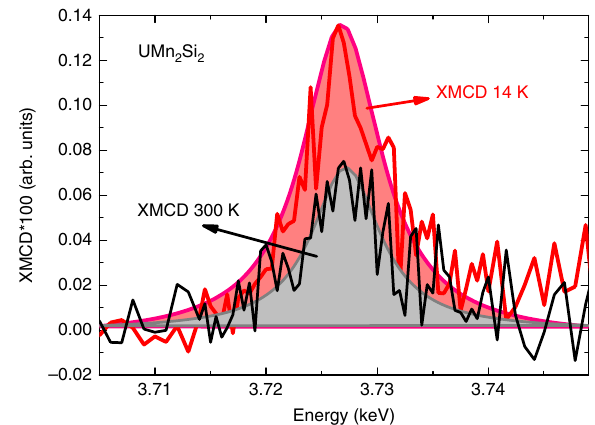
Fig. 3 Isolated probe of the 5 f contribution. Uranium M 4 -edge X-ray Magnetic Circular Dichroism (XMCD) spectra measured for the UMn 2 Si 2 compound at temperatures of 14 K and 300 K. The area of the XMCD spectra is proportional to the magnetic moment solely of the 5 f orbitals. By the ratio between the area of the two XMCD spectra we estimate that the uranium 5 f magnetic moment increases by a factor 2.2, in good agreement with the results obtained at uranium L 3 edge (see main text). Note that due to the direct (3 d → 5 f ) transition in the dipolar channel at the M 4,5 the signal amplitude here is a factor of 50 higher than at the L 3 edge data as shown in Fig. 2